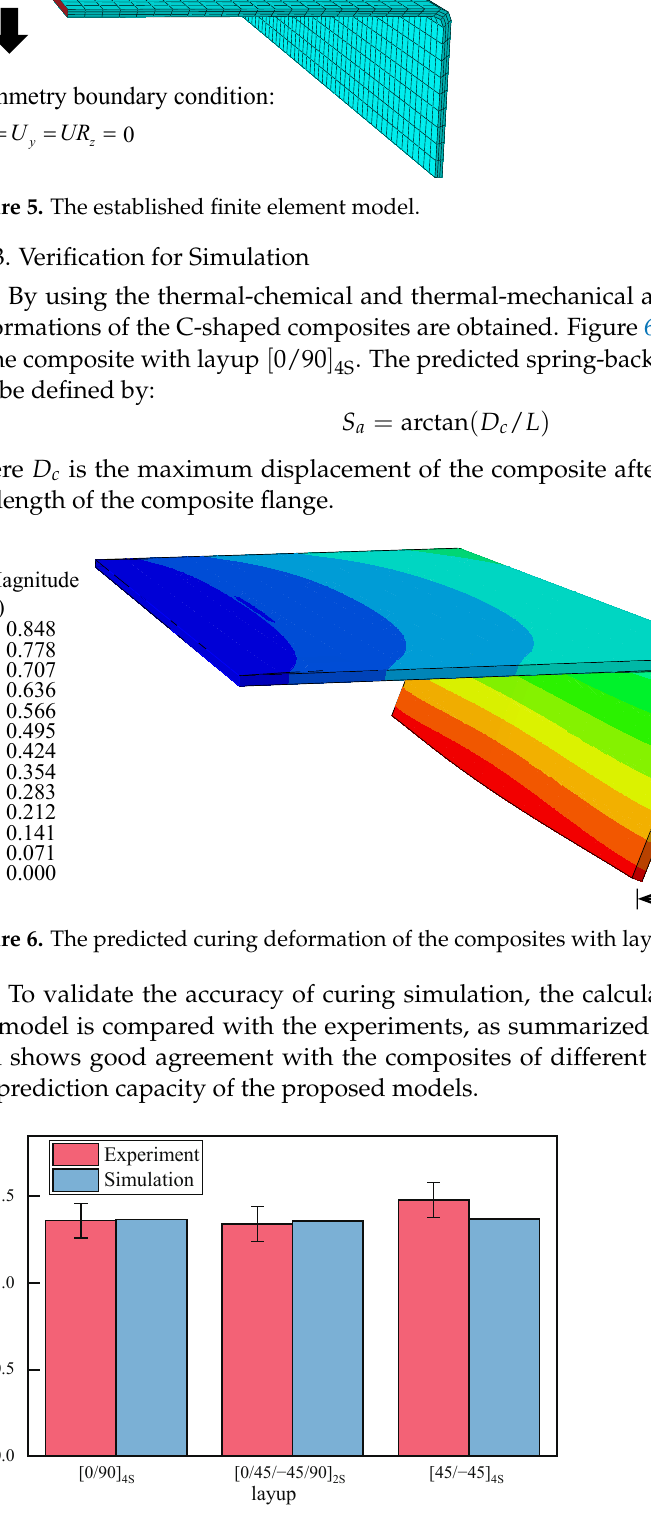
Figure 7. The predicted curing deformation of the composites with layup [ 0/90 ] 4S